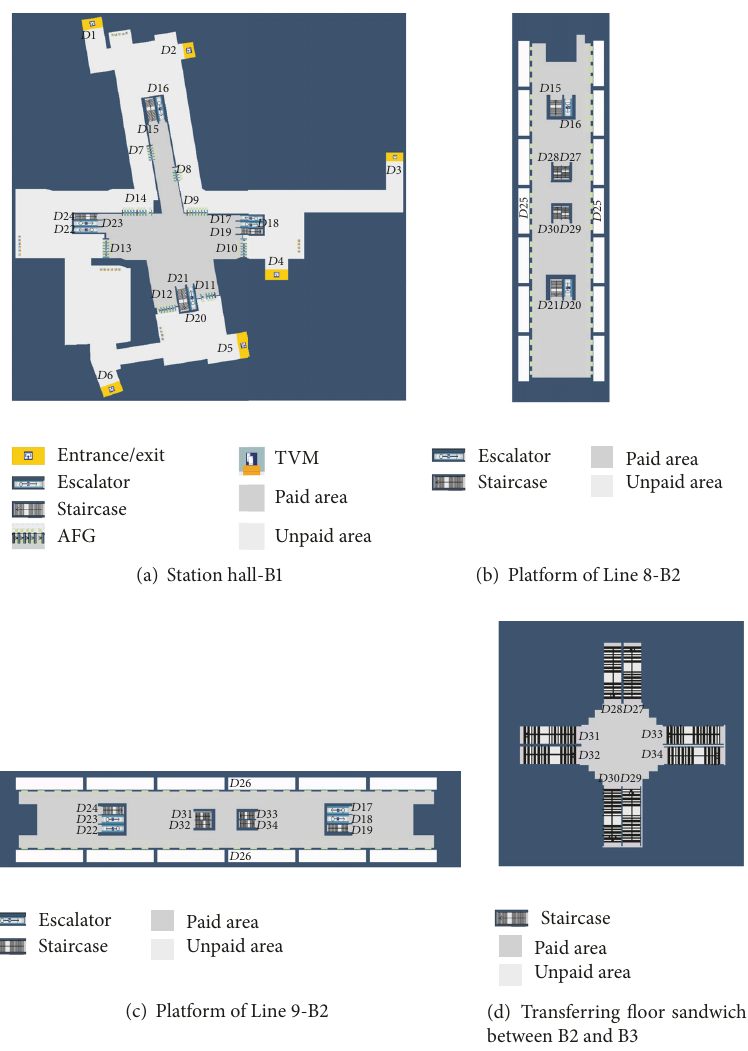
Figure 4: Sketches of LJB station: (a) station hall, (b) platform of Line 8, (c) platform of Line 9, and (d) interlayer for transfer.